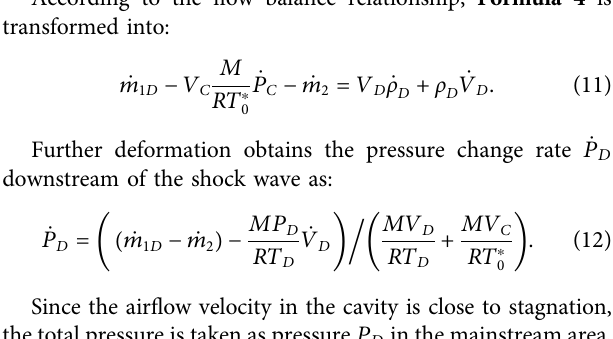
TABLE 1 | Comparison of calculation parameters of different